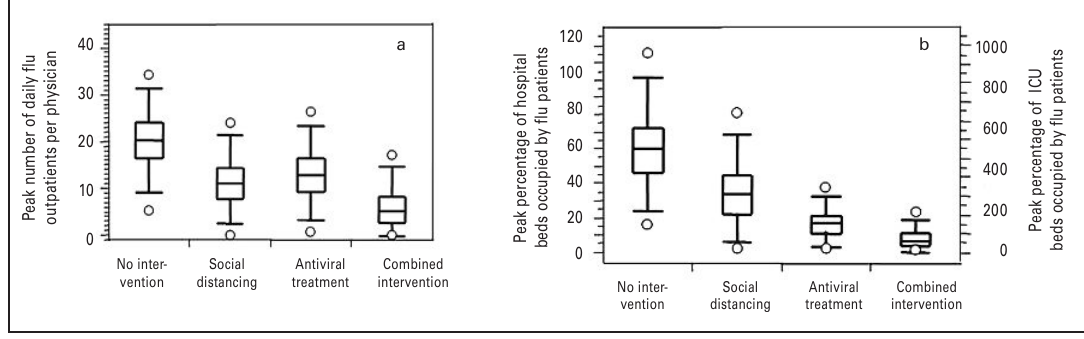
Simulation results of different intervention scenarios resulting from 100000 random parameter sets as explained in the text (population size 100000 individuals). Box and whiskers plots show percentiles from bottom to top: 0.5, 2.5, 25, 50, 75, 97.5 and 99.5%, representing 99% of the simulation results between circles, 95% between whiskers and 50% within the box, respectively. (a) Peak number of outpatient visits per physician in practice, (b) left axis: peak percentage of available hospital beds occupied by influenza patients, right axis: peak percentage of available ICU beds needed for influenza patients.